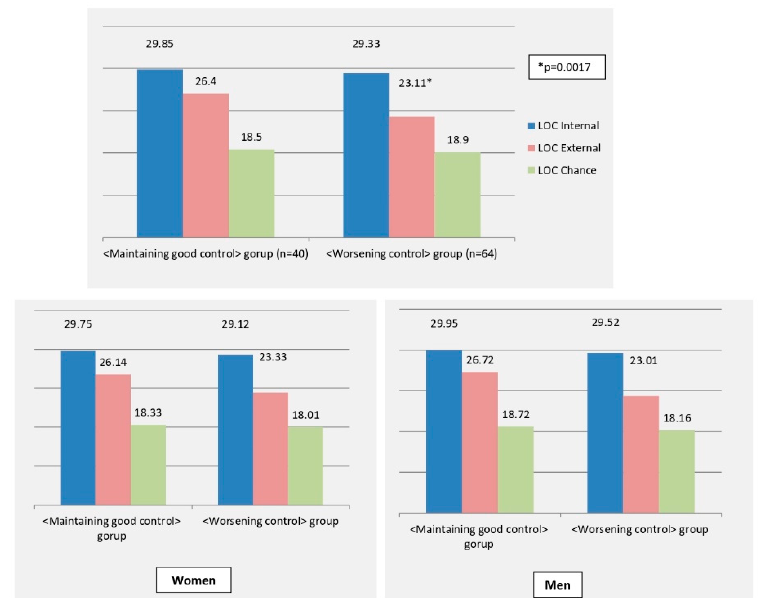
Figure 1. LOC scores in the <Worsening control> and <Maintaining good control> groups. < Worsening control > group (n = 64): subjects who over time presented a worsening of glycemic control and/or requested an intensification of hypoglycemic therapy vs. baseline. < Maintaining good control > group (n = 40): subjects who over time improved their glycemic control or maintained a good glycemic control.